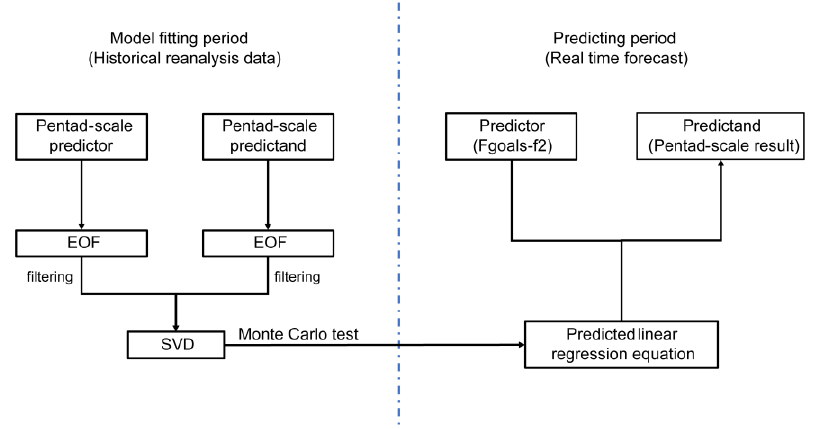
Figure 1. Flowchart for the pentad DSDM.